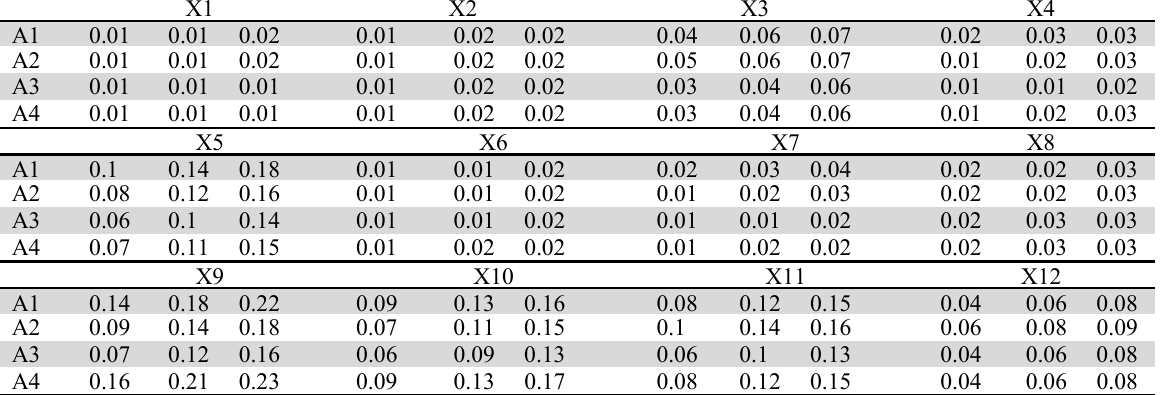
Weighted normalized fuzzy decision matrix for Kei Kecil Sub-District X1